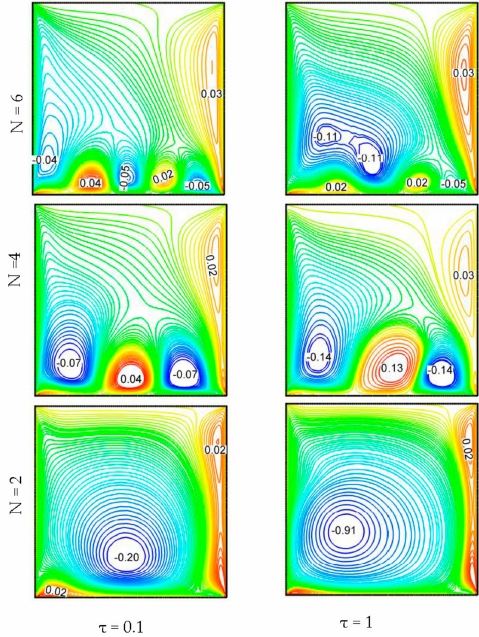
Figure 6. Influence of the even values of N on streamlines for the selected values of τ with Gr = 10 6